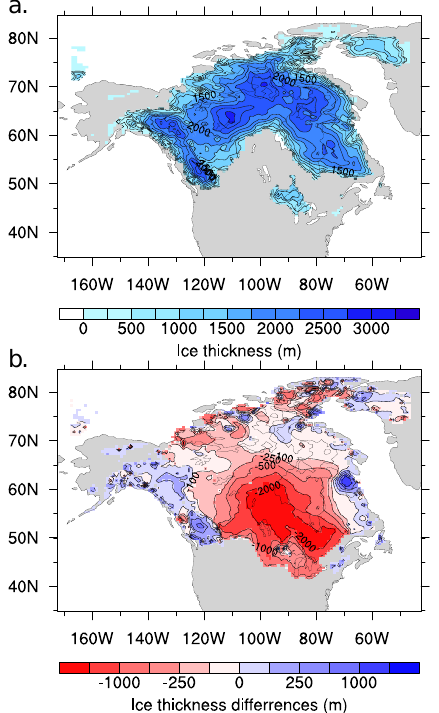
Figure 12. Ice field at 50ka for a simulation using parameter nn9894. (a) Ice thickness with SG turned on. (b) Ice thickness dif- ferences between simulations with the SG model turned on and off.